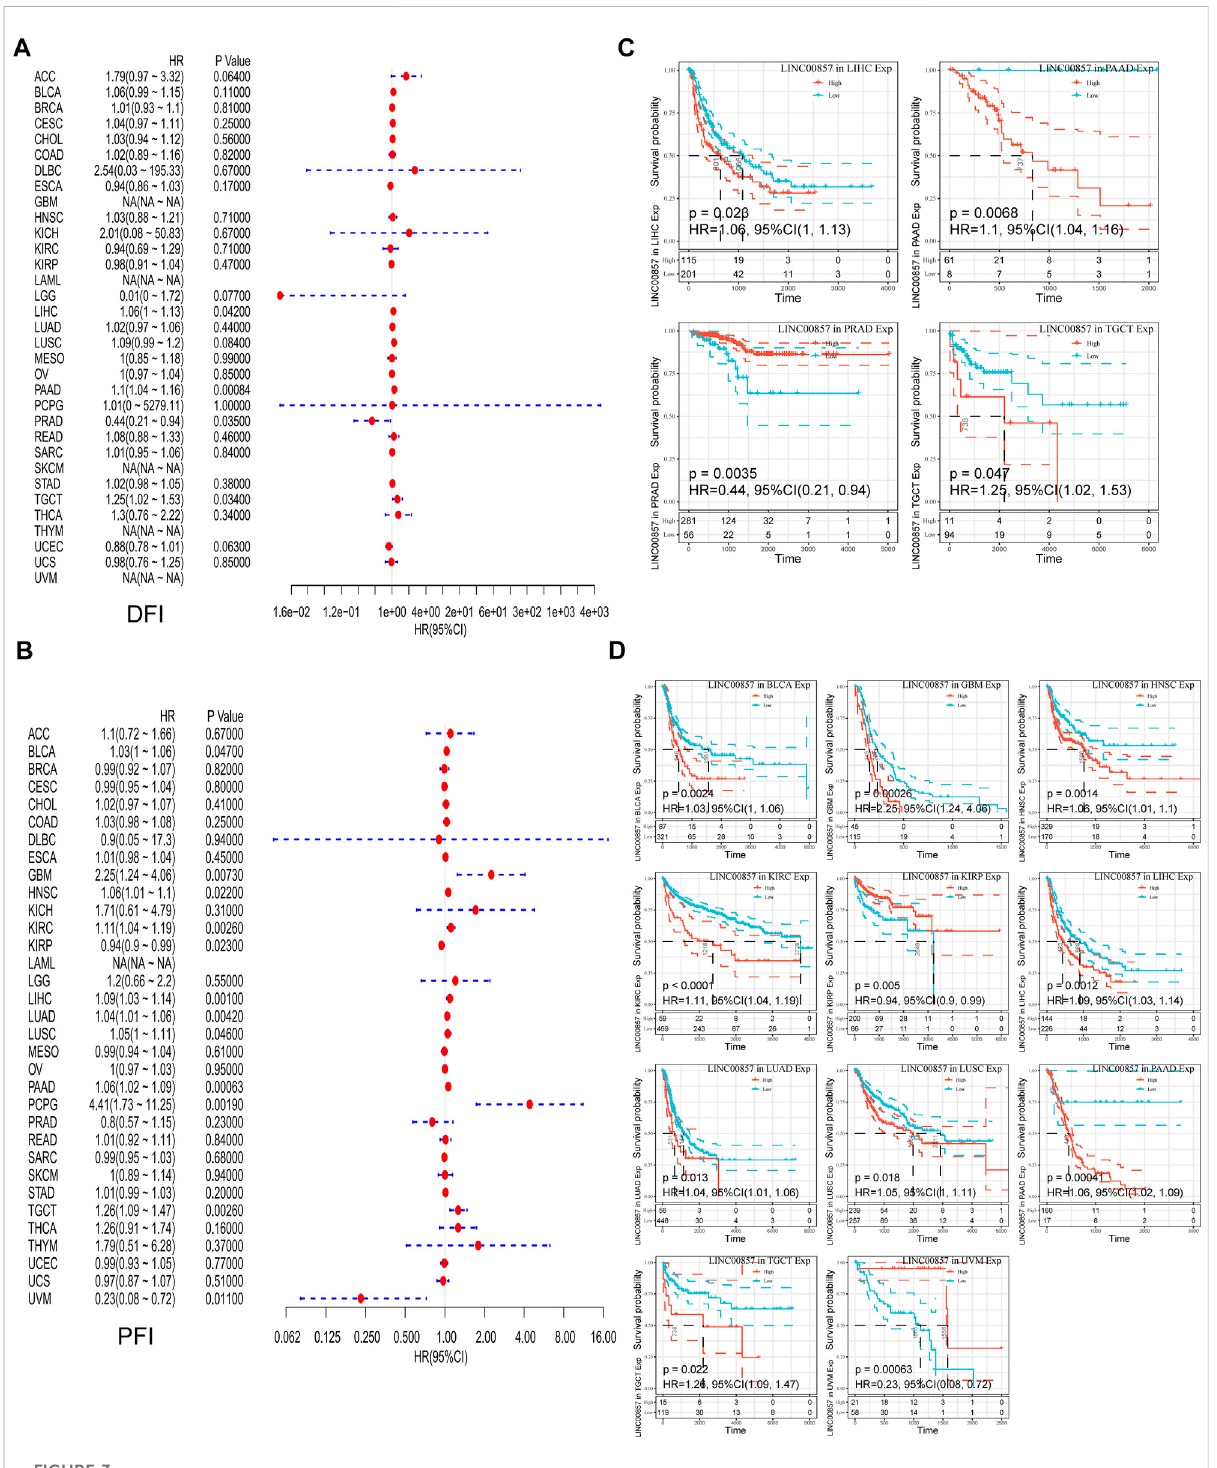
The correlation between LINC00857 expression and DFI and PFI in pan-cancer. (A,B) Cox regression analysis of LINC00857 on DFI and PFI for different neoplasms was depicted by forest diagrams. (C,D) Kaplan-Meier curves presented the prognostic value of LINC00857 for DFI or PFI ( p <